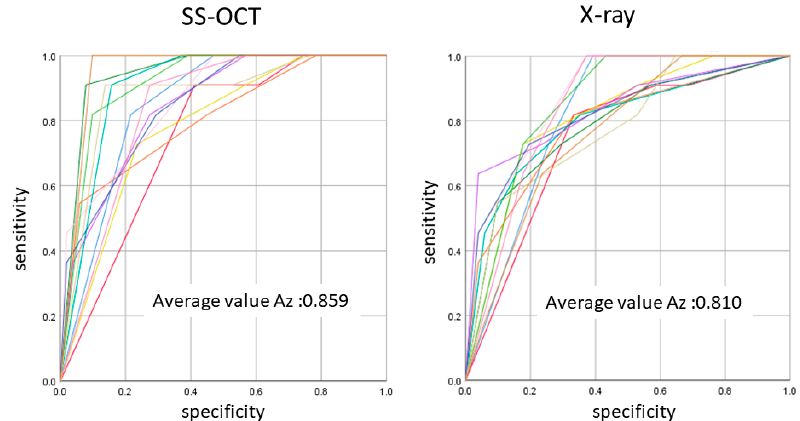
Figure 7. The average Az value of ROC with 13 lines represented by the Az value from thirteen examiners. There was a difference between OCT and radiography in the accuracy of detection in occlusal caries in three cutoff points ( p < 0.05).